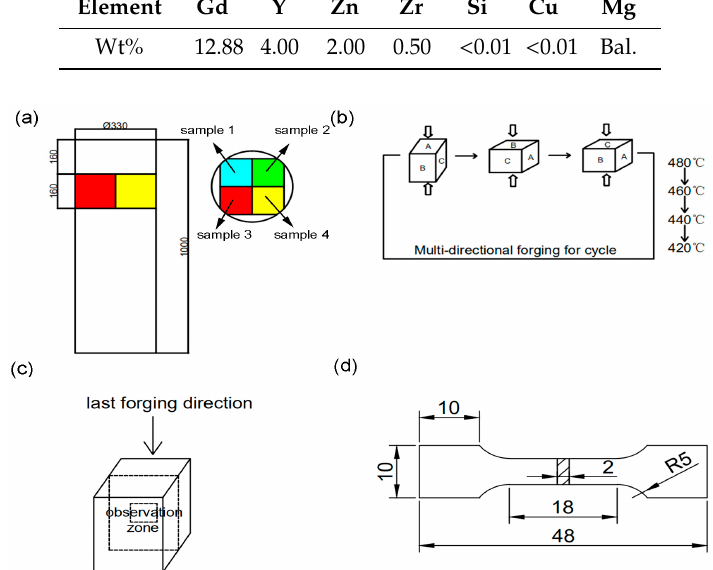
Figure 2. ( a ) The position of the experimental samples out of the homogenized rod, ( b ) the schematic representation of geometry changes during each pass of the MDF process, ( c ) microstructure analysis zone for samples after MDF, ( d ) dimensions of tensile samples (in mm).